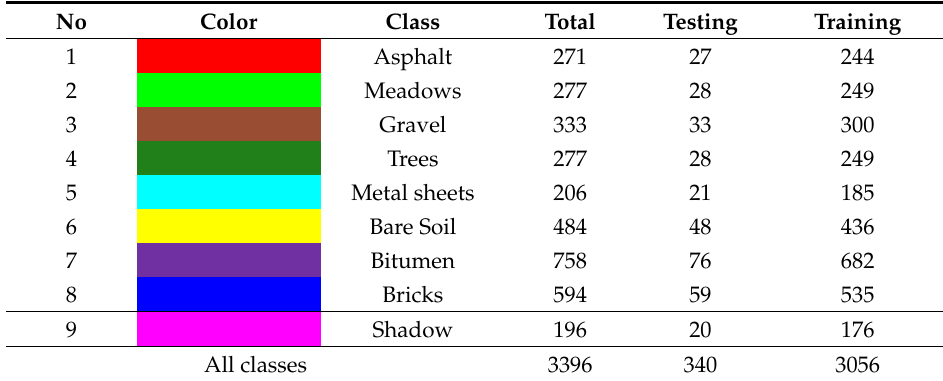
Table 1. Land-cover classes and numbers of samples in the part-PaviaU HSI.